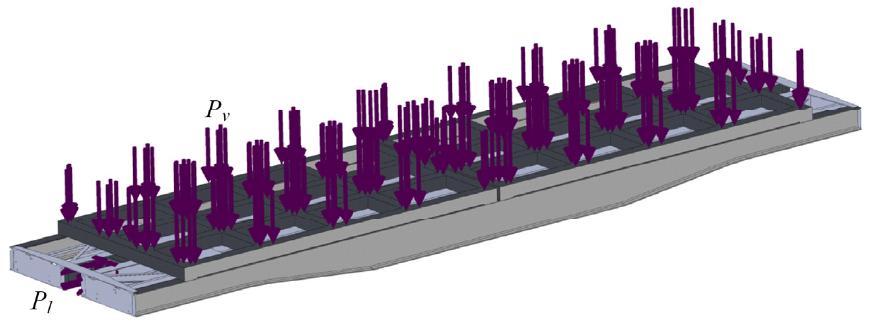
Figure 10. Design diagram of the bearing structure of a flat wagon loaded with removable modules. The longitudinal load P l equalling 3.5 MN was applied to the rear coupler support of the flat car. The fittings of the removable module had the bonds with the rigidity 20 kN/m and the viscous resistance coefficient 30 kN · s/m. The friction forces between the fittings of the removable modules and the fixed fittings of the flat wagon were neglected. The results of the calculation are given in Figure